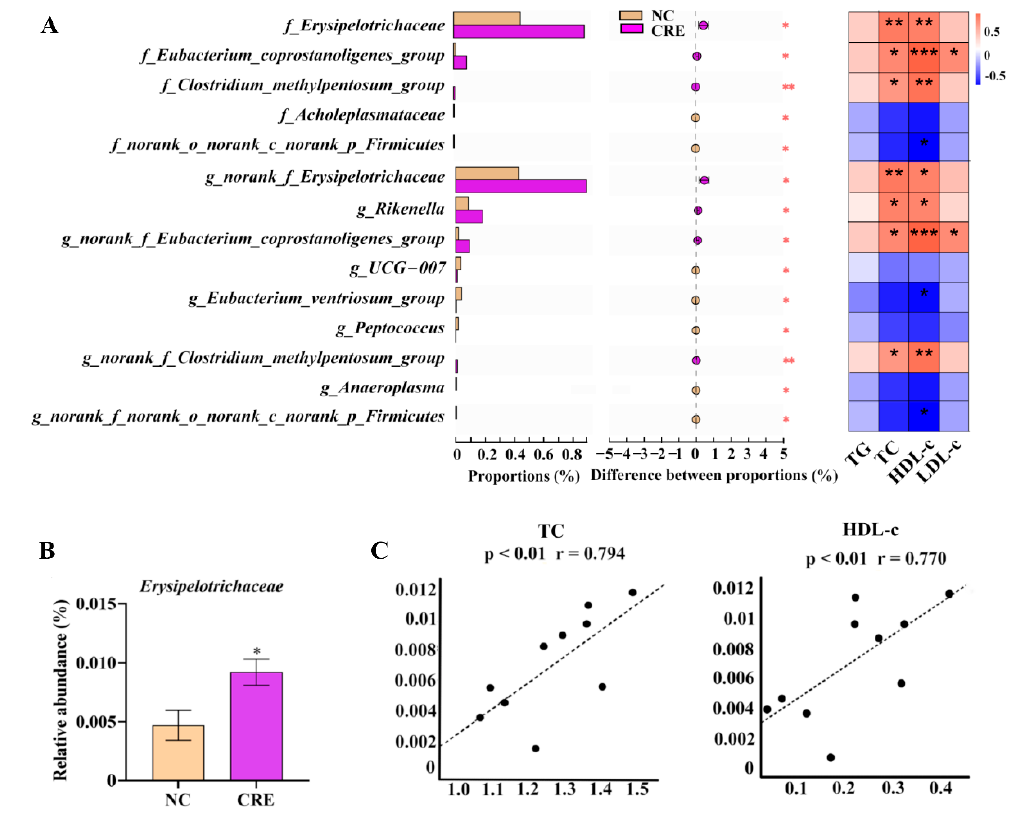
Figure 2. ( A ) Significantly differential gut microbes at the family and genus levels in CRE infection group compared with controls ( left ), and their correlations with the hepatic lipid profile of TG, TC, HDL-c and LDL-c ( right ). ( B ) Relative abundance of intestinal Erysipelotrichaceae at the family level; ( C ) correlation plot of Erysipelotrichaceae family with hepatic levels pf TC and HDL-c. Vertical coordinates are the relative abundance values of Erysipelotrichaceae (%), and the horizontal coordinates are the TC or HDL-c levels (mmol/L), respectively. Data are presented as mean ± SEM. P values were determined using an unpaired, two-tailed Student’s t-test. * p < 0.05, ** p < 0.01, *** p < 0.001.